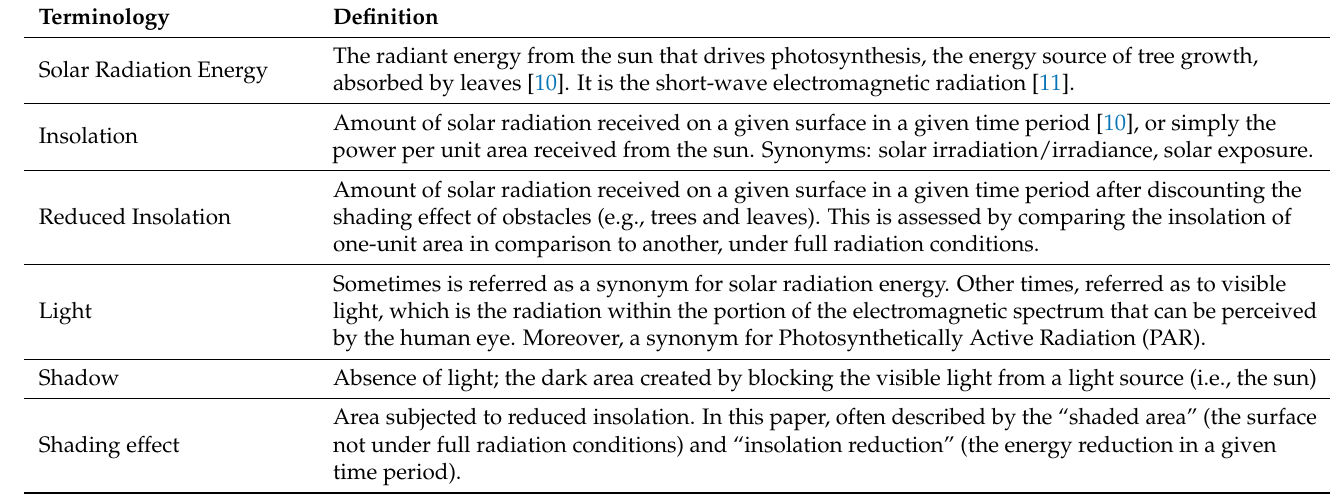
Table 1. Useful concepts, terminologies and definitions used within the framework of this